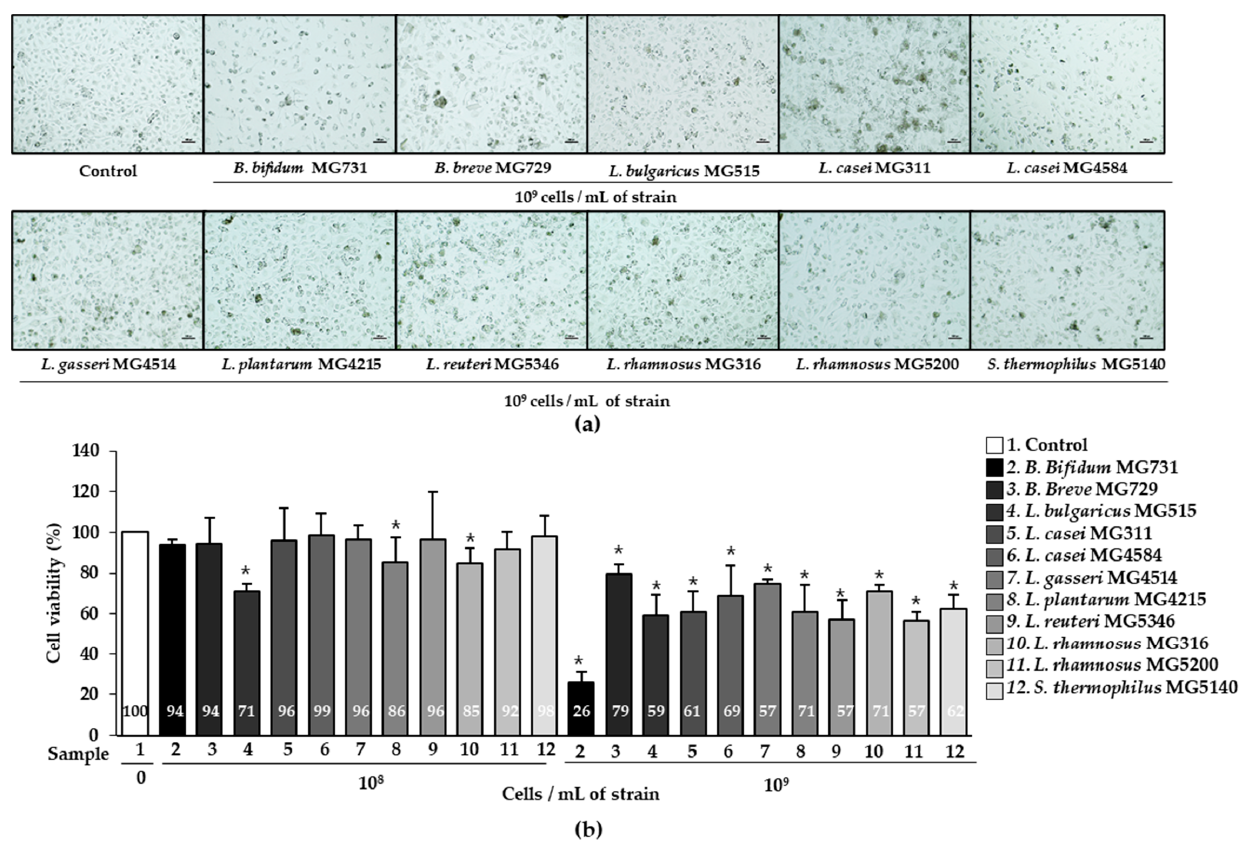
Figure 1. Cytotoxicity of heat-killed Bifidobacterium and Lactobacillus in human gastric cancer MKN1 cells analyzed by MTT assay. ( a ) Cell morphology and ( b ) cell viability (%). Results are presented as mean ± SD in three independent experiments. * p < 0.05 compared with the control.